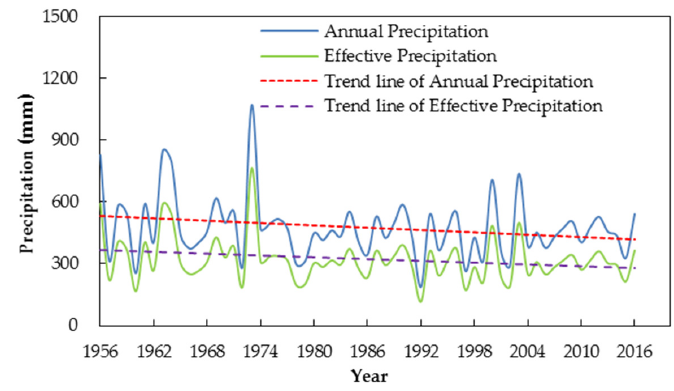
Figure 4. The temporal variations of precipitation from 1956 to 2016 in Quzhou County.